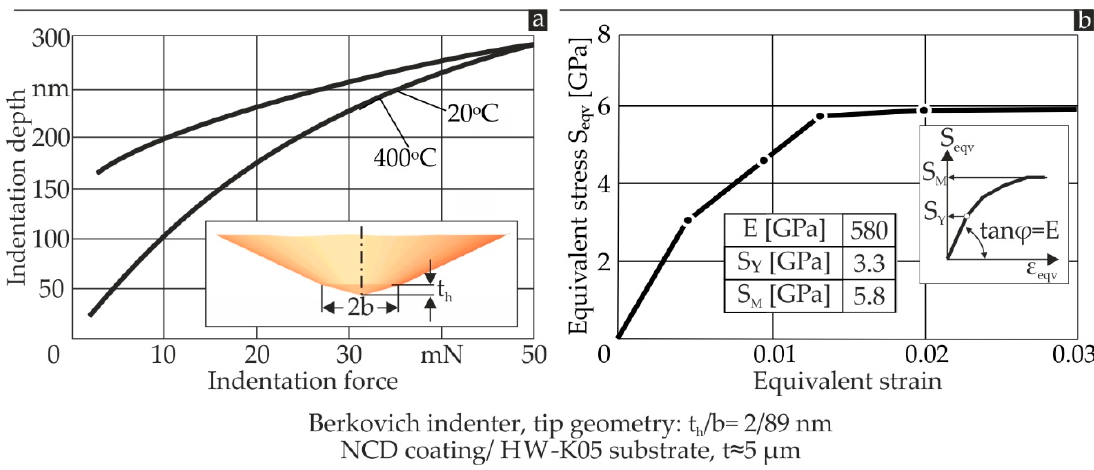
Figure 4. ( a ) Nanoindentation load-displacement curves; ( b ) Calculated stress-strain curves of HW-K05 cemented carbide inserts before and after annealing at 400 °C.